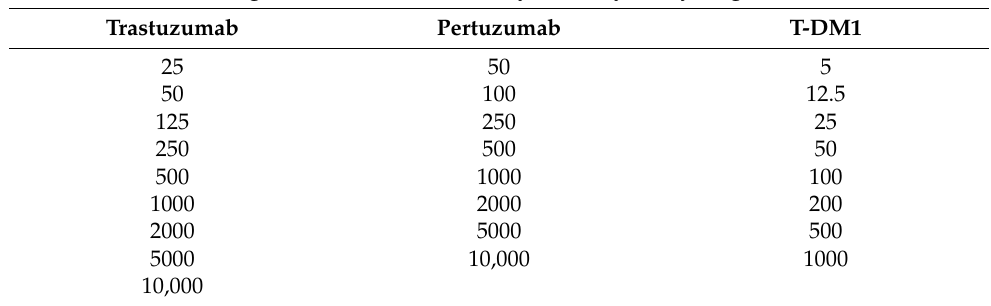
Table 1. Concentrations of trastuzumab ( µ g/mL), pertuzumab ( µ g/mL) and T-DM1 ( µ g/mL) used in the cytotoxicity assays. Cells were exposed to drug for 72 h and the antiproliferative effects were